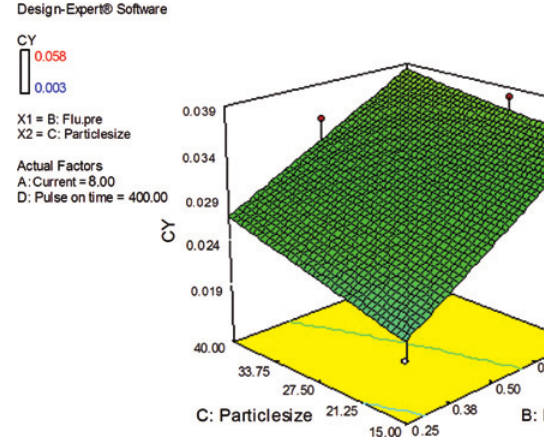
Figure 9 Interactive effect of current and particle size on SR.